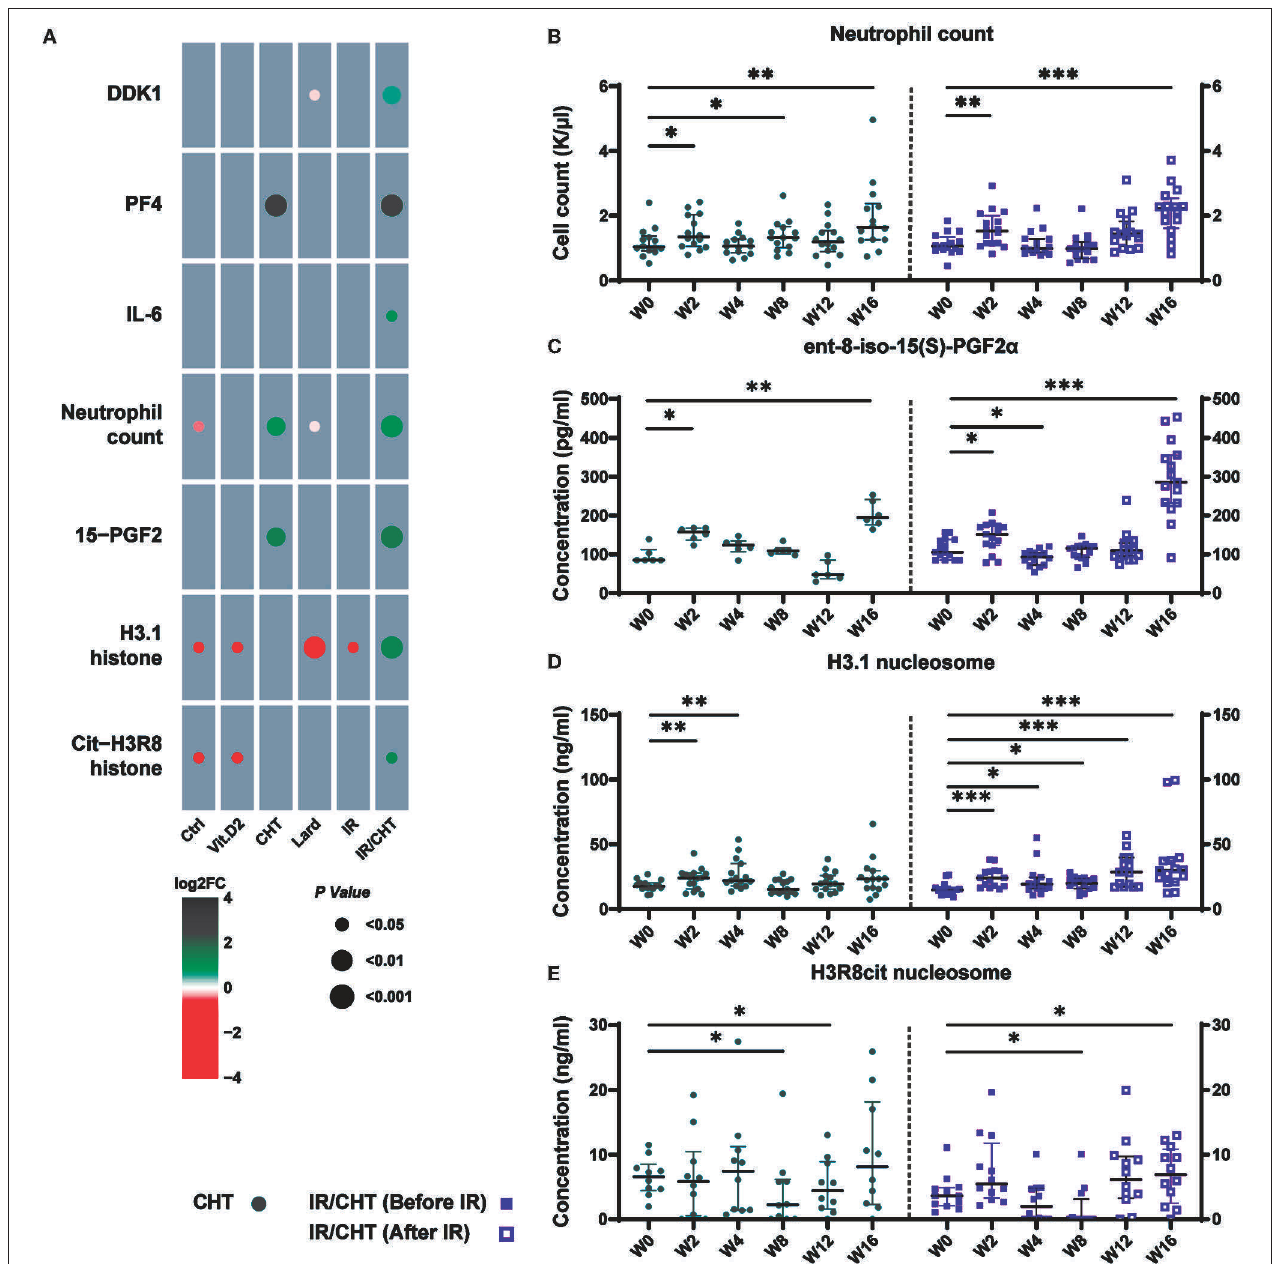
FIGURE 6 | Effect of cholesterol- and lard-enriched diets, and irradiation on the circulating biomarkers of calcification, platelet activation, inflammation, oxidative stress, and on circulating nucleosomes. (A) Bubble plot represents concentration fold-change of biomarkers of interest between week 16 (W16) and baseline. Over time evolution of neutrophil count. (B) 15-PGF2 (C) and circulating nucleosomes (D,E) . Graphs represent median with P25-P75 interquartiles. * P ≤ 0.05; ** P ≤ 0.01; *** P ≤ 0.001 (Wilcoxon signed-rank test; Ctrl, n = 7–13; Vit.D2, n = 7; CHT, n = 10–15; Lard, n = 7–12; IR, n = 7; IR/CHT, n = 15).